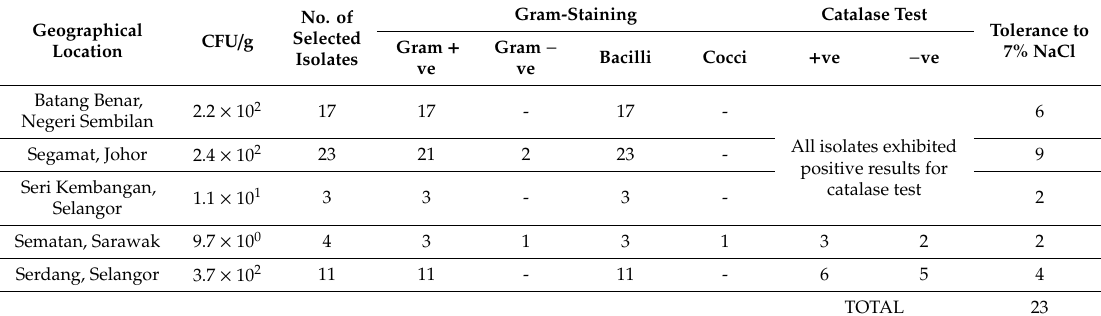
Table 1. Preliminary selection of Bacillus strains isolated from stingless bee honey from di ff erent geographical locations. CFU: colony-forming